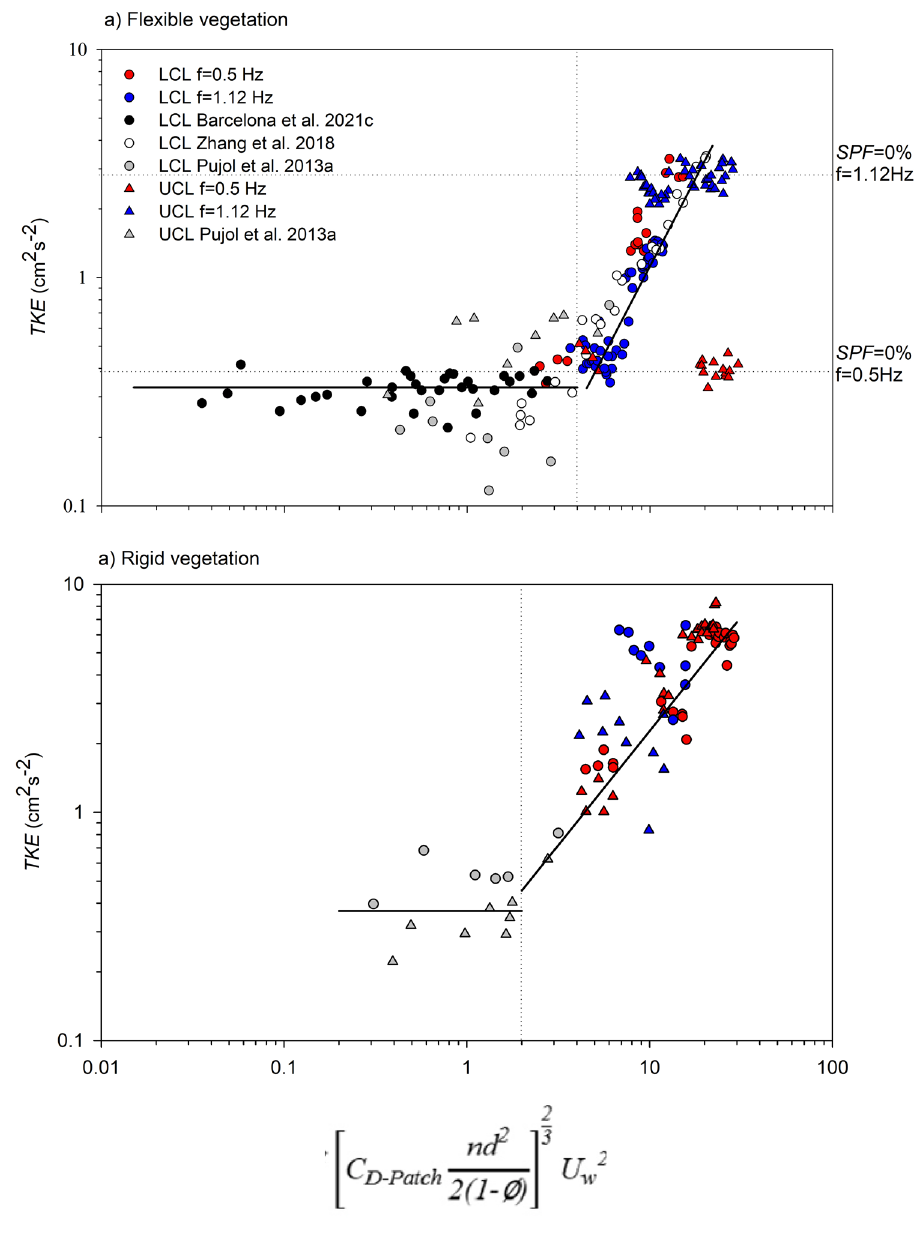
Figure 4. TKE versus et al. 25 , and Zhang et al. 20 for flexible vegetation have been included and data from Pujol et al. 16 for flexible vegetation and rigid vegetation have been included as well. The vertical dashed line indicates the threshold that separated the two behaviours. The solid line corresponds to the best fit line of the data points to the model for dashed lines in ( a ) correspond to the TKE for cases without plants and for both wave